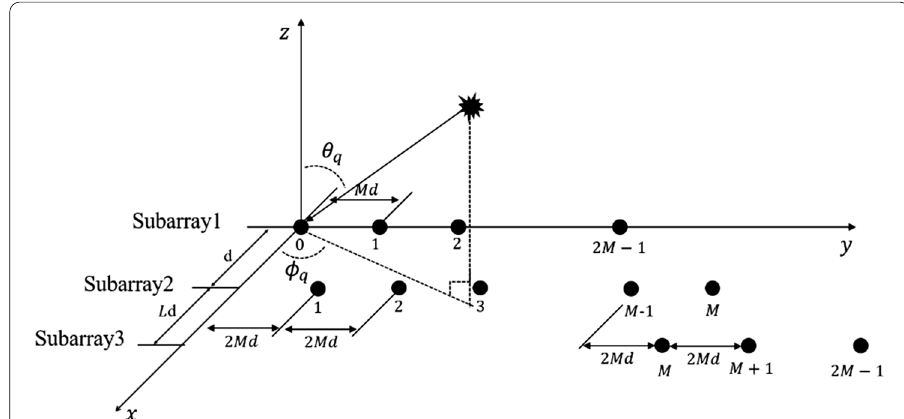
Fig. 2 MIMO array model after virtual